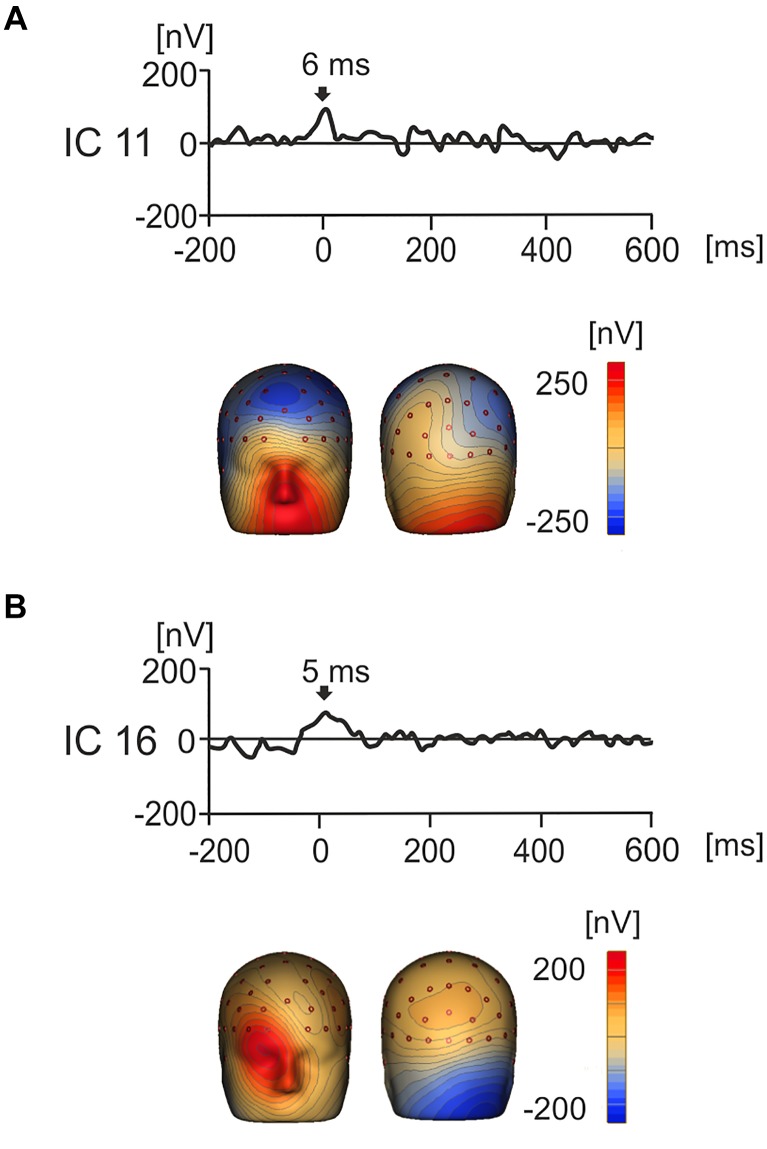
Grand average IC waveforms and corresponding 3D whole head topographic maps (nV) for two ICs that represent eye movement related artifacts. (A) IC11 showed peak activity around image onset (6 ms), with a positive maxima around the eyes, suggesting that this component represented left biased saccadic eye movement related activity. (B) IC16 showed peak activation around product image onset (5 ms) and positivity maximal around the right eye, suggesting that that this component represents right-biased saccadic eye movement related activity.